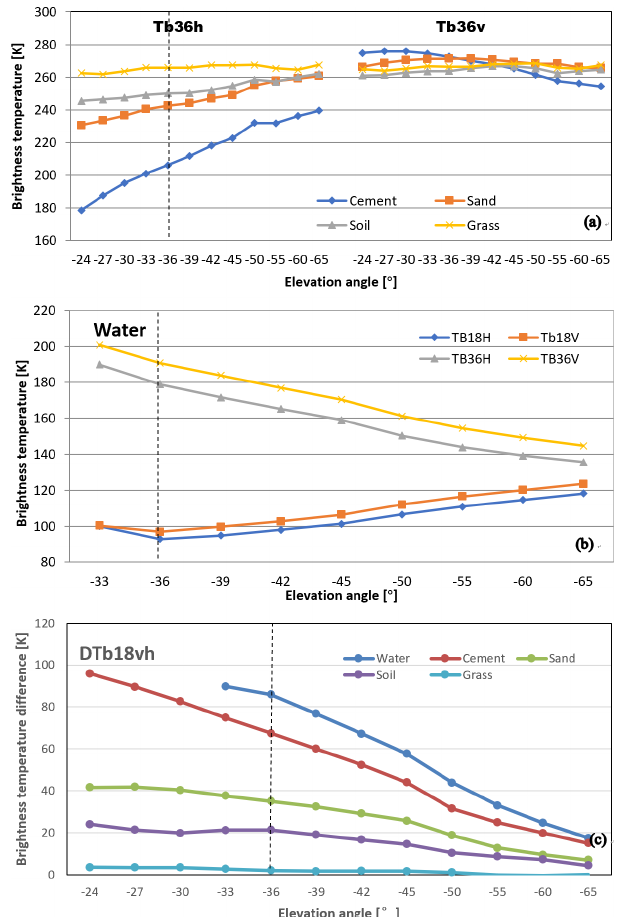
Figure 6. Variations in the observed T b over different land surfaces (a) and water surface (b) as well as T b polarized difference (c) with the elevation angle in October 2018. The vertical dotted line corre- sponds to an elevation angle of 36 ◦ .